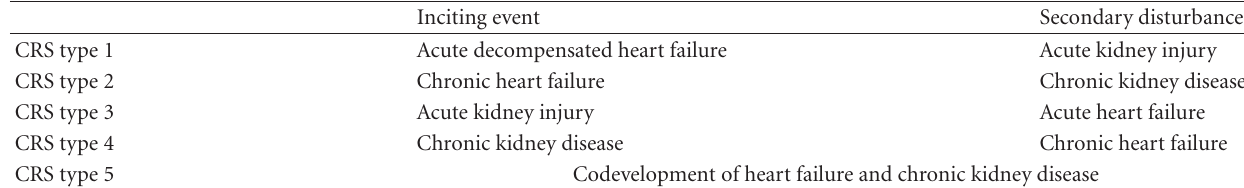
Table 2: ADQI classification system of the cardiorenal syndrome